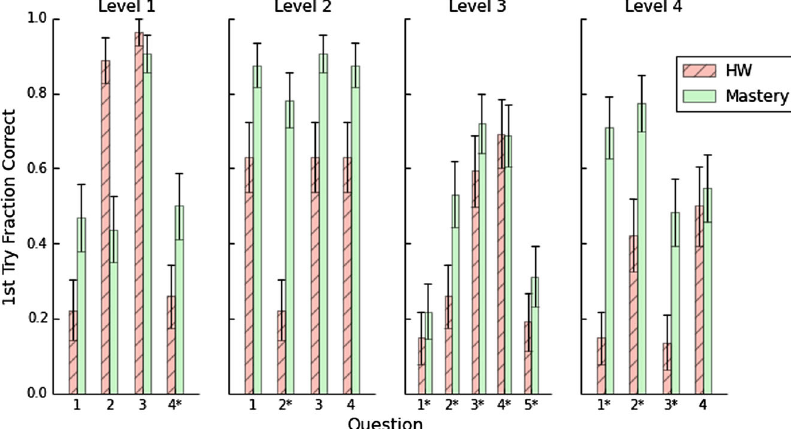
FIG. 3. Fraction of students with a correct response on their first try for each question. Asterisk indicates question had different formats for the two groups (multiple choice for the mastery and free response for the homework